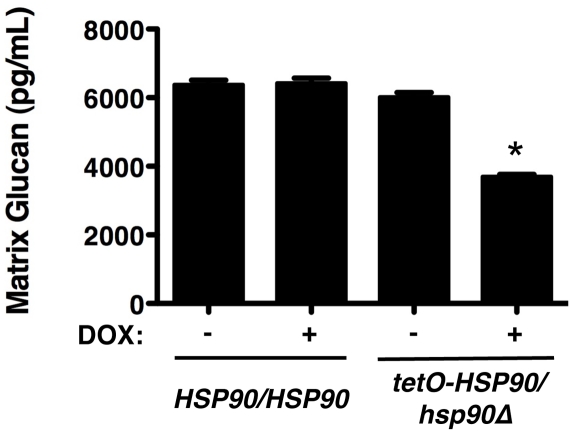
Depletion of Hsp90 reduces biofilm matrix glucan.Strains of C. albicans were cultured in 6-well polystyrene dishes for 48 hours with or without 20 µg/mL doxycycline (DOX). Matrix samples were collected and matrix β-1,3 glucan levels were meausured using a limulus lysate based assay. Asterisk indicates P<0.01 (ANOVA, Bonferroni's Multiple Comparison Test) compared to all other conditions.